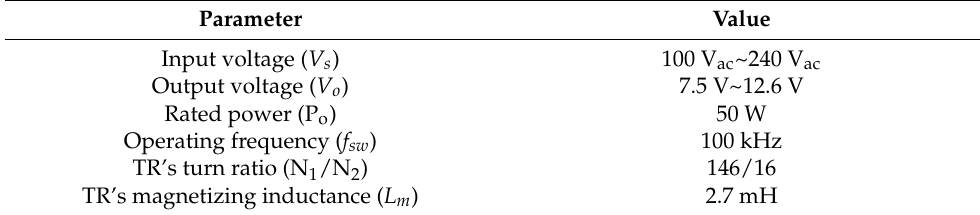
Table 2. Specifications and related electrical parameters of the